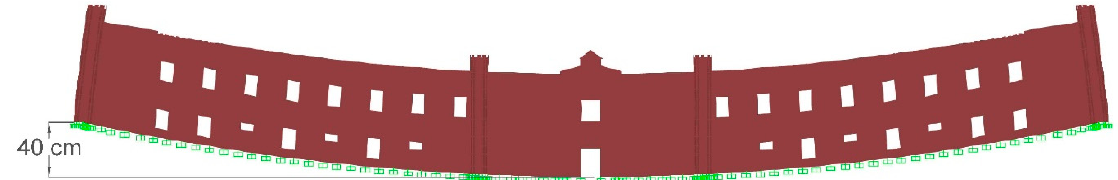
Figure 14. Model deformation resulting from a combination of loads plus the pattern of parabolic settlements (displacements scale factor 1:20).